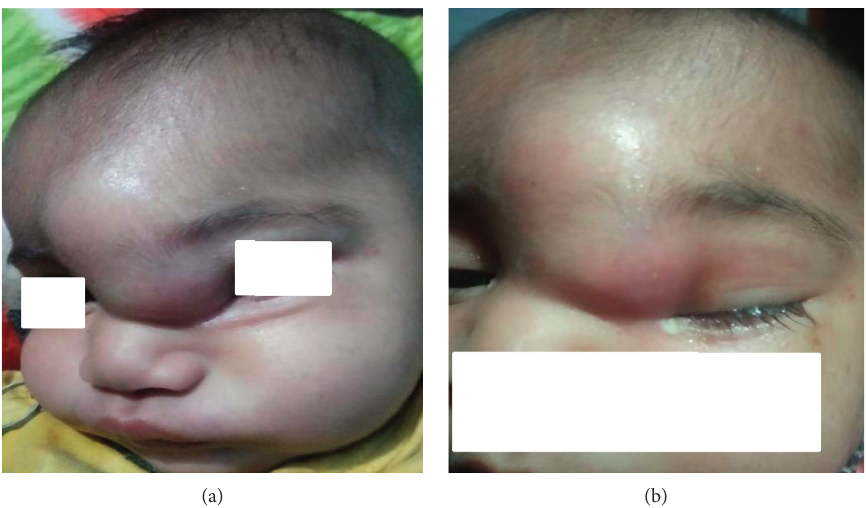
Figure 1: (a) Well-circumscribed swelling around the frontal bone area approximately (7 × 5 cm) involving left epicanthal fold and swelling of the left eyelid, which developed initially and subsided. The image obtained from the mother. (b) Swelling recurred after 4 weeks showing signs of inflammation. Purulent discharge from the left eye. The image obtained from the